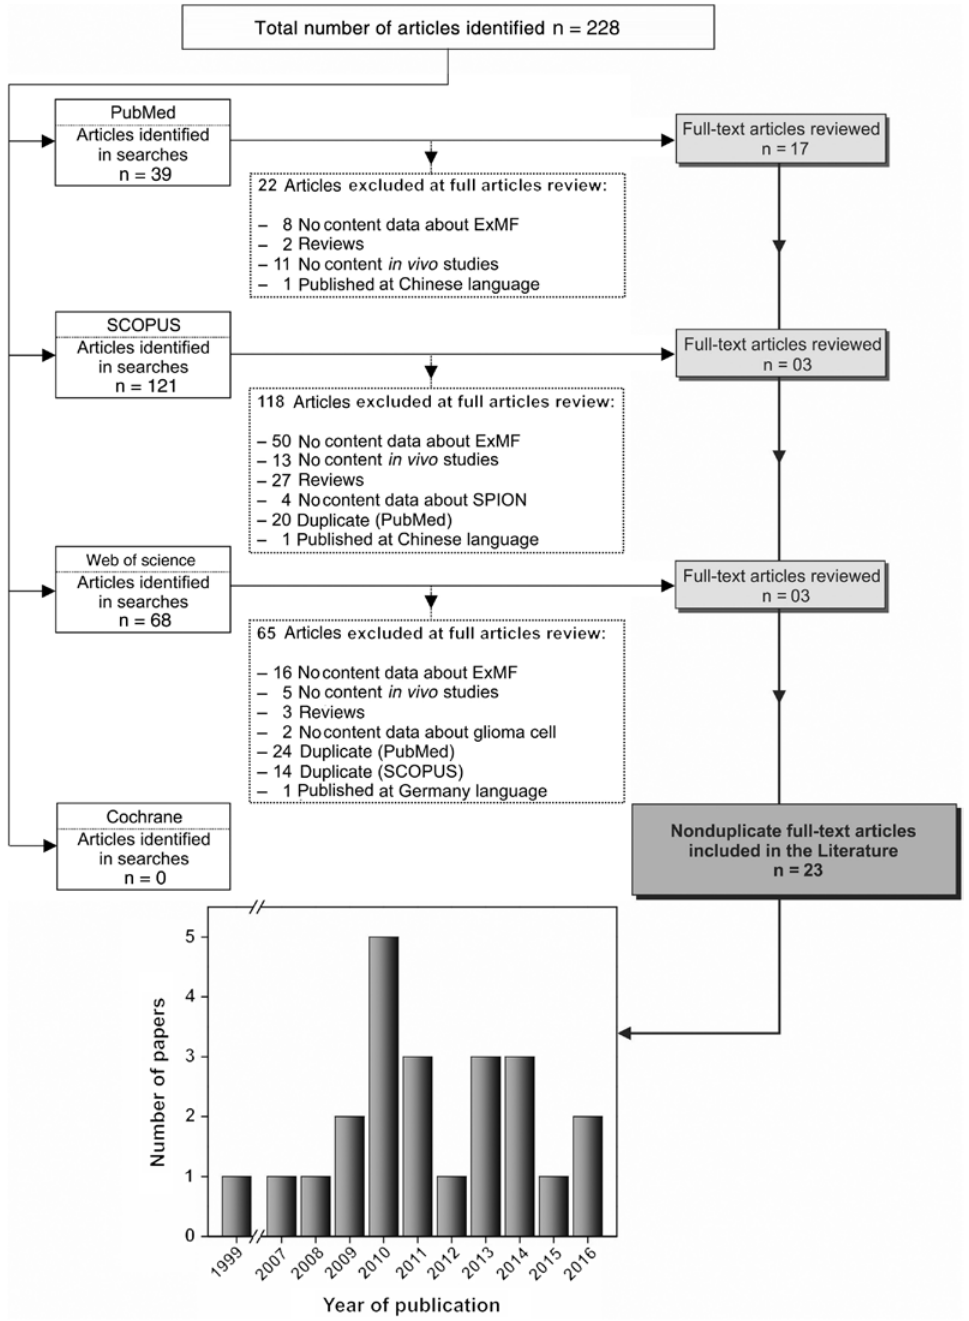
Figure 2: Flowchart of selection process of studies included in the